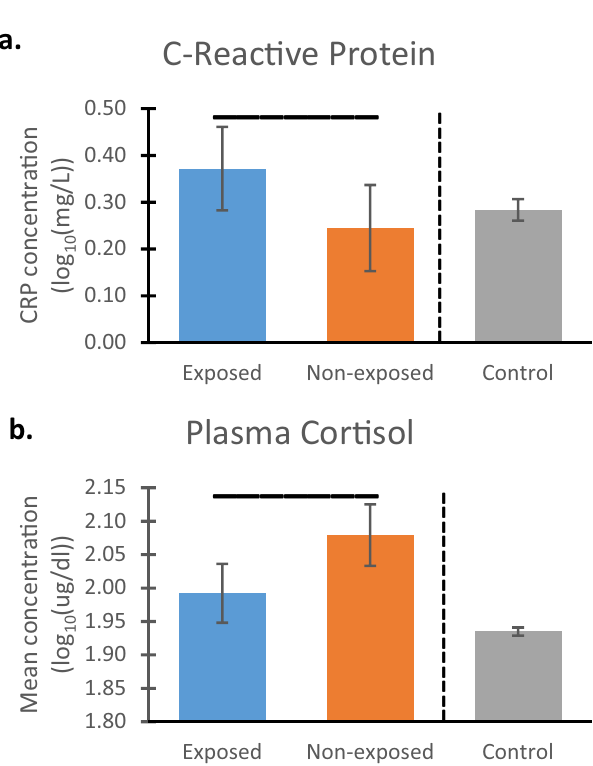
Fig. 2 Physiological measures. Statistical comparisons between monkeys exposed vs. non-exposed (blue and orange bars, respectively) to wild fi re smoke prenatally show exposed animals had ( a ) elevated mean levels of C-reactive protein (CRP; measured as milligrams/Liter) and b reduced mean concentrations of plasma cortisol (measured as micrograms/deciliter), compared to monkeys that were not prenatally exposed. Data were log 10 transformed; error bars re fl ect 95% Con fi dence Intervals (CI), and values are adjusted for the covariate. Overhead bars indicate signi fi cant effects: for CRP, p = .05 (two-tailed), and for cortisol, p = .008. To the right of the dotted lines are the corresponding values for the full control cohort (mean, 95% CI). Comparison of the overlap in CI between the groups in the target cohort with the control cohort revealed that, for